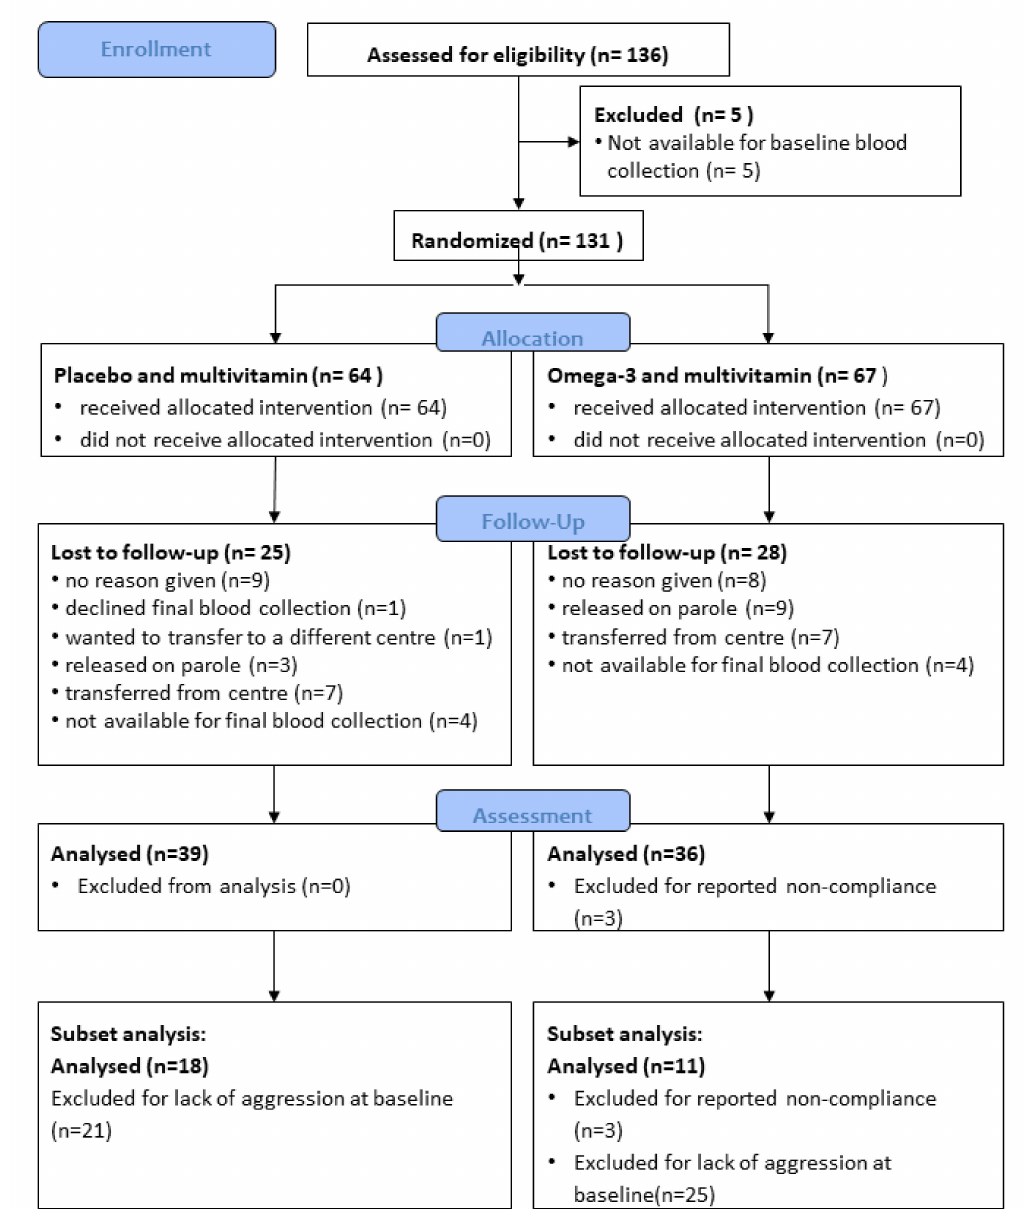
Figure 1. CONSORT flow diagram of recruitment, follow-up, assessment of the whole cohort, and assessment of the subset of aggressive participants, as defined by an Inmate Behaviour Observation Scale (IBOS) of 1 or greater at